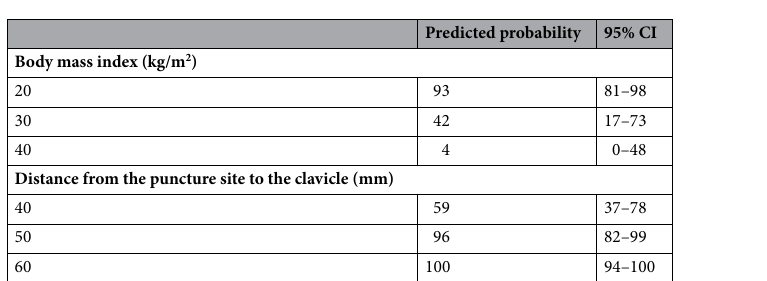
Table 3. Predicted probabilities for successful visualization of parallel guidewire image based on representative values of body mass index and distance from the puncture site to the clavicle. CI confidence